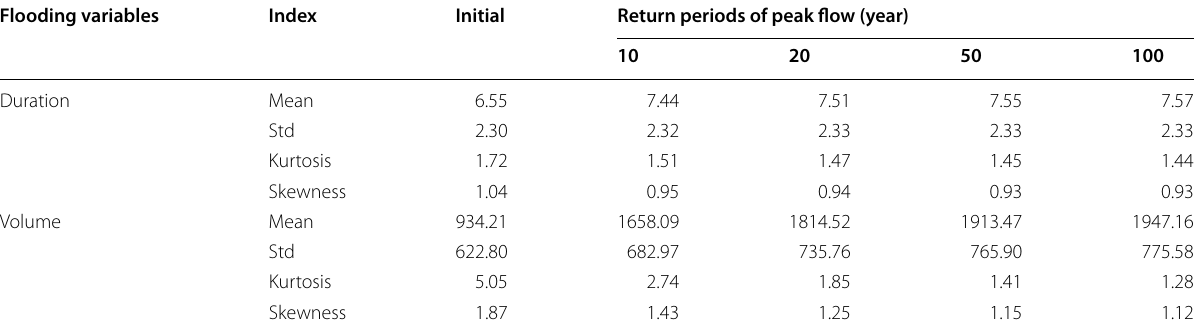
Table 10 Statistical characteristics of the conditional PDFs of flooding duration and volume under different peak flow return periods Flooding variables